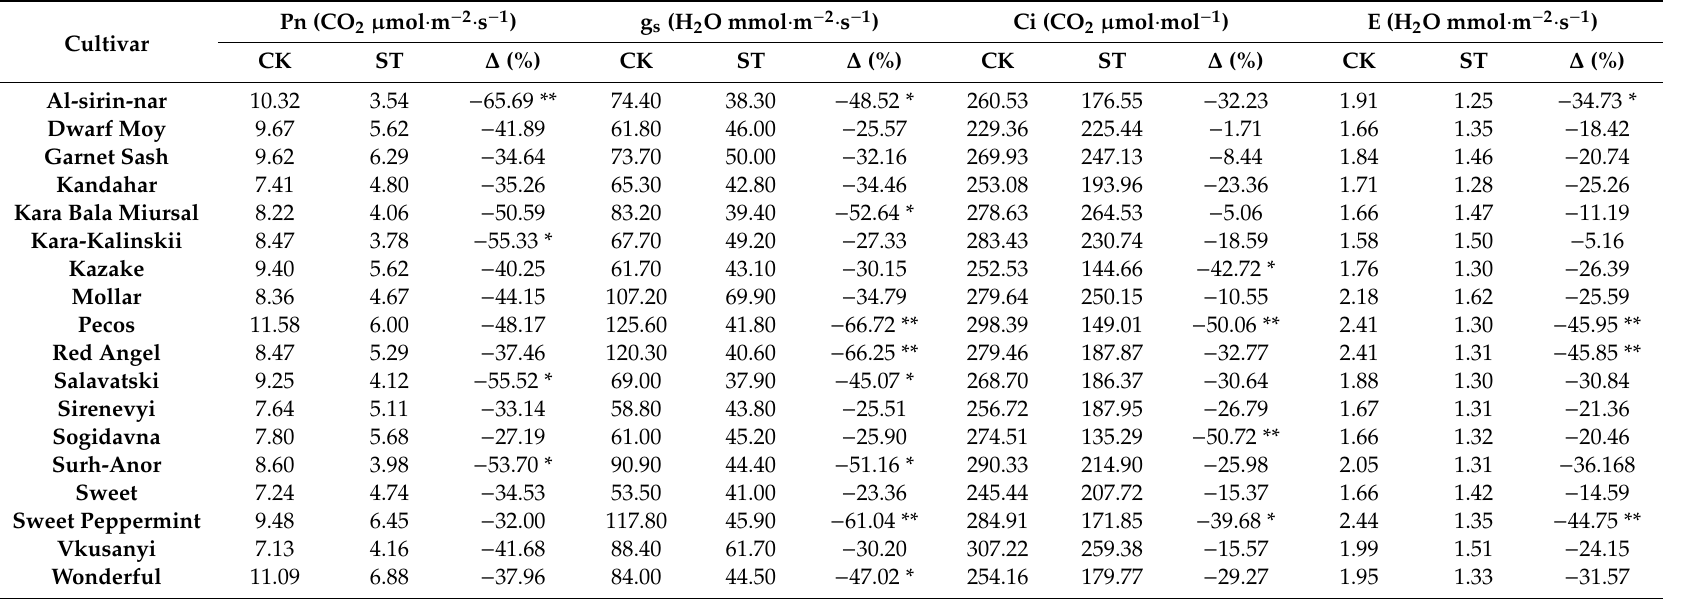
Table 4. Photosynthetic parameter: leaf net photosynthesis (Pn), stomatal conductance (gs), intercellular CO2 concentration (Ci), and transpiration (E) of pomegranate leaves under salt